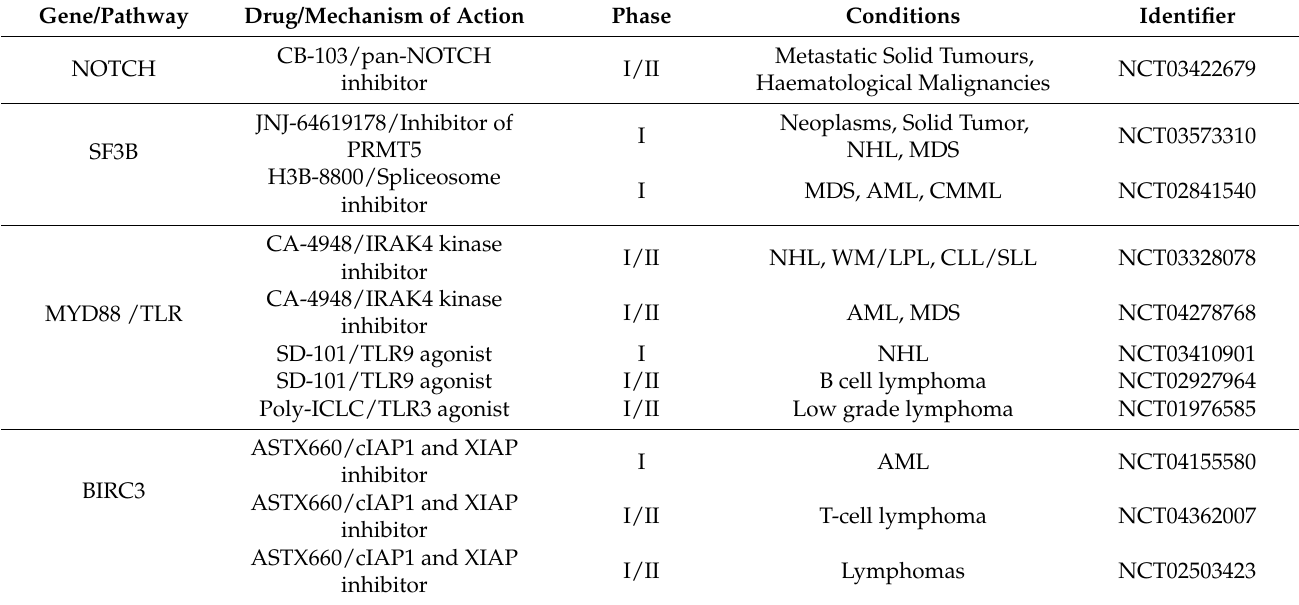
Table 1. Ongoing clinical trials associated with targeting mutations/pathways in haematological malignancies.